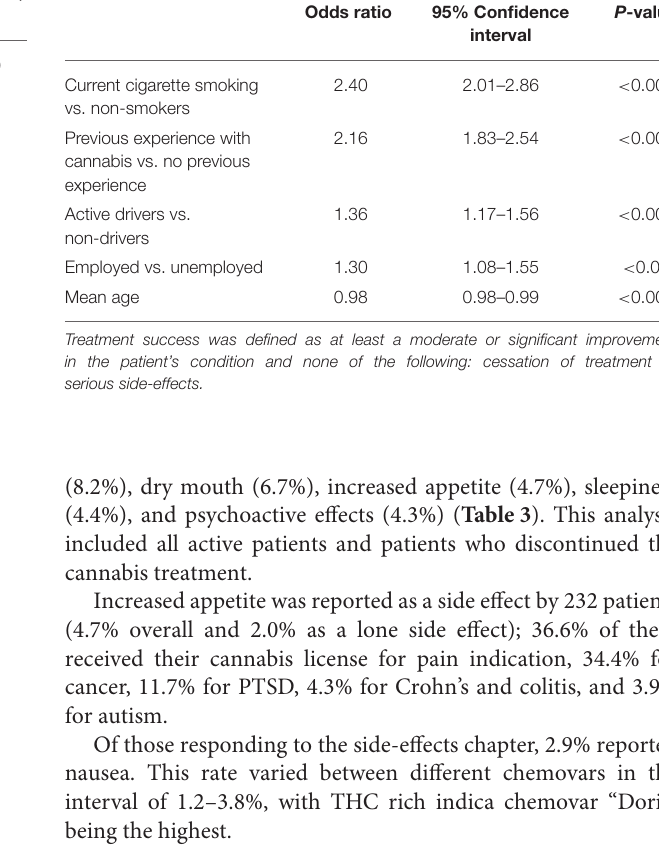
TABLE 4 | Logistic regression multivariable analysis of factors associated with treatment success after 6 months. Odds ratio 95% Confidence